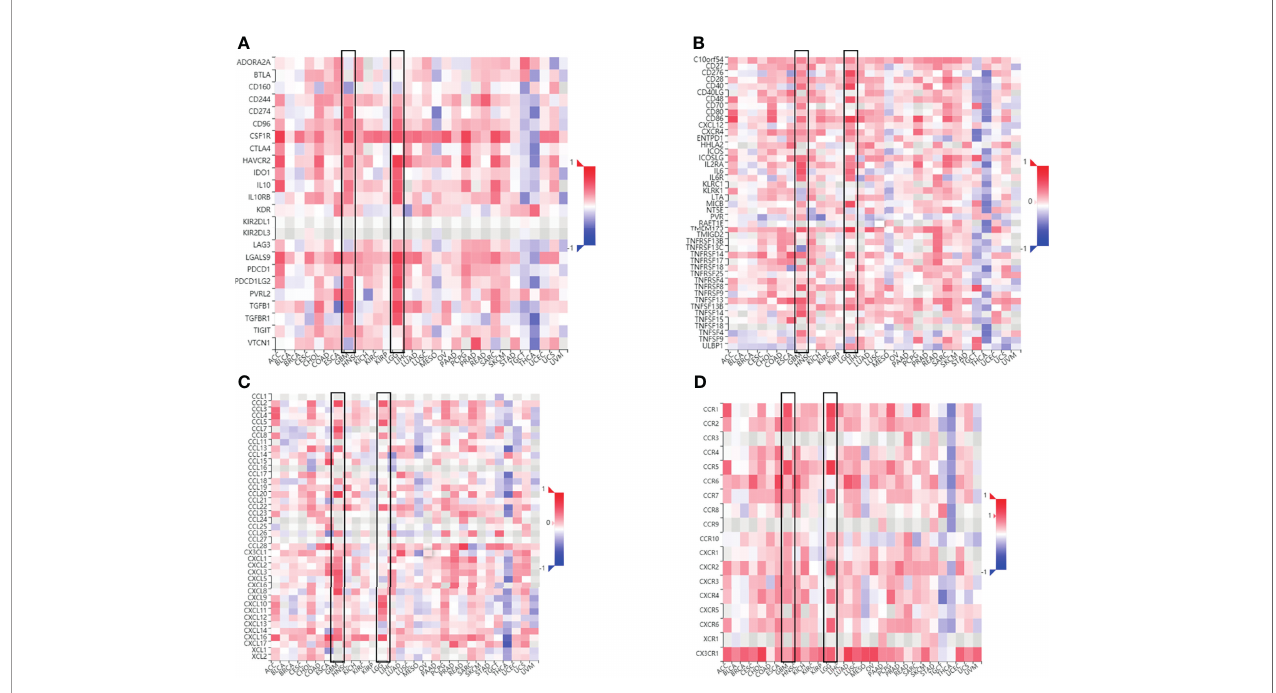
FIGURE 7 | Correlation between FCGBP expression and immune markers. Correlation between FCGBP mRNA expression and immune-related molecules. (A) Correlation between FCGBP and glioma immunosuppressive agents. (B) The correlation between FCGBP and glioma immunostimulants. (C) Correlation between FCGBP and chemokines in gliomas. (D) The correlation between FCGBP and glioma